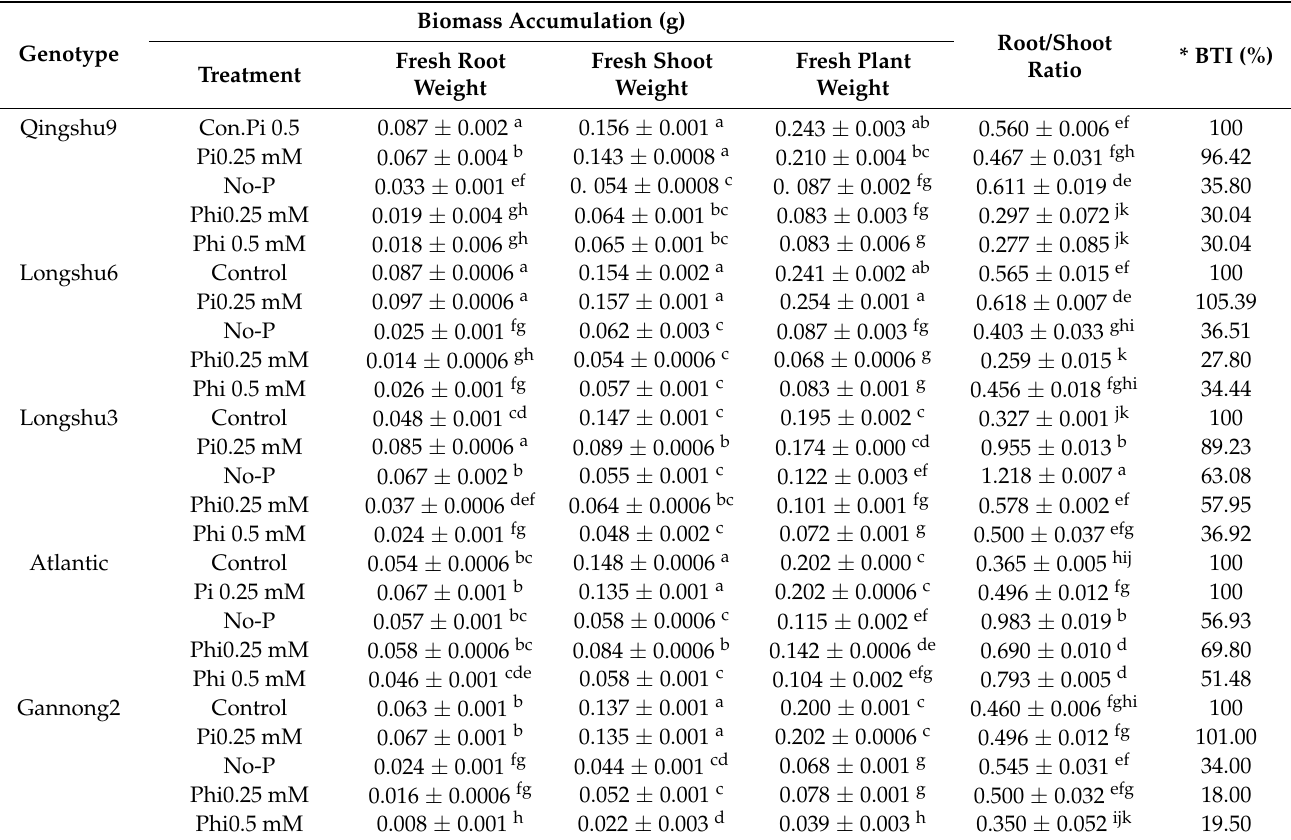
Table 1. Effect of Phi, Pi and No-P supply on fresh biomass, root/shoot ratio and biomass tolerance index of five potato genotypes studied under in vitro